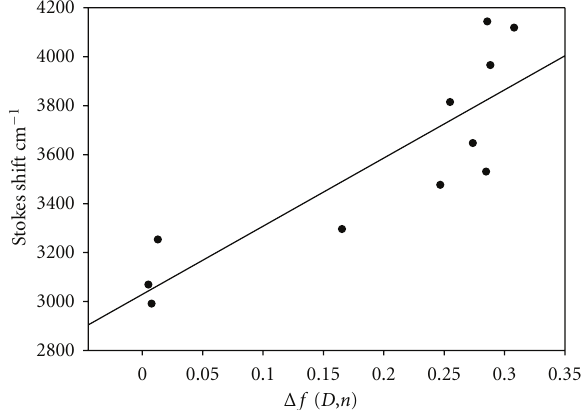
Figure 3: Stokes shift versus polarity Δ f of